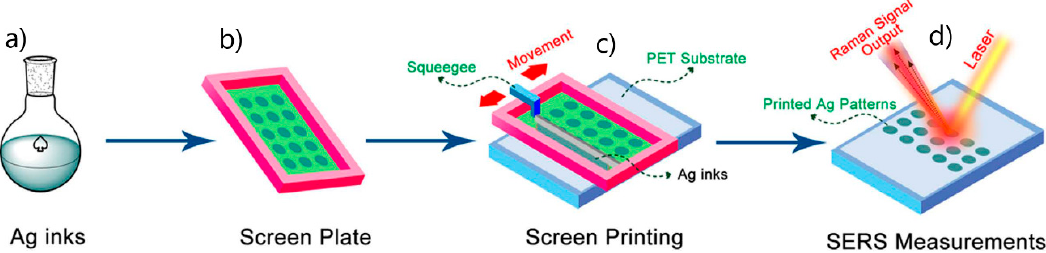
Figure 25. Illustration of the screen-printing process. The nanoparticle ink ( a ) and a screen plate ( b ) are used to print an array of SERS active areas with the help of a squeegee ( c ); SERS measurements are carried out on the printed spots ( d ). Reproduced with permission from Wu et al. [338] under Creative Commons 4.0 license (https: // creativecommons.org / licenses / by / 4.0 /